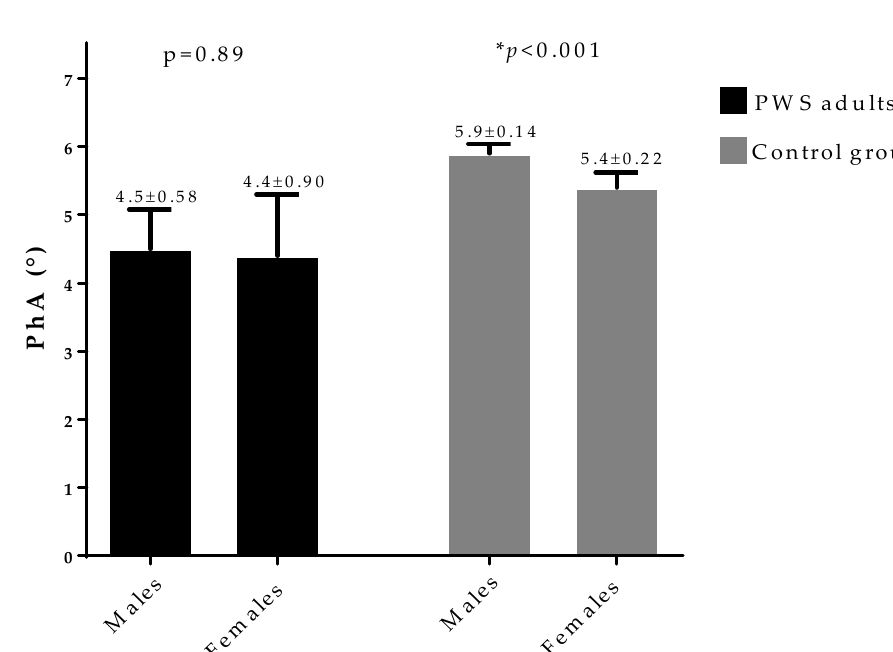
Figure 1. Di ff erence in PhA in PWS adults and control group, according to gender. A clear gender di ff erence in PhA was evident only in the control group, with higher PhA in males compared with females ( p < 0.001). PWS, Prader–Willi syndrome; PhA, phase angle. * A p- value < 0.05 means a significant di ff erence.